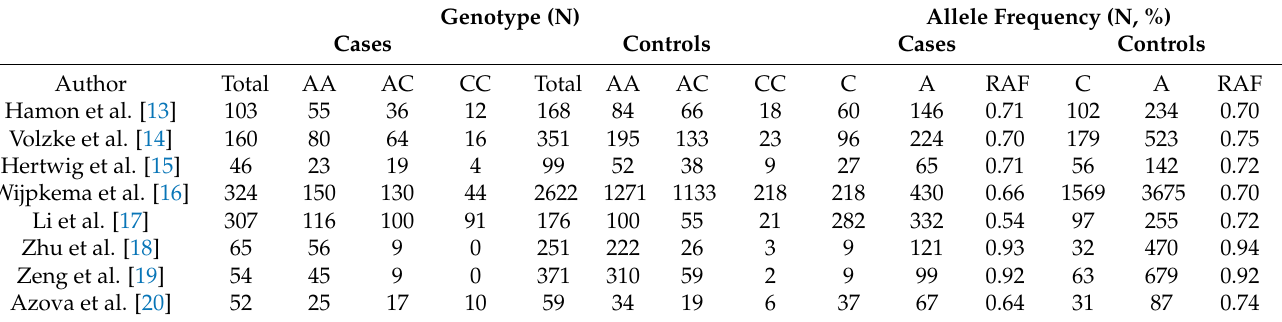
Table 2. The results of Newcastle-Ottawa Scale.